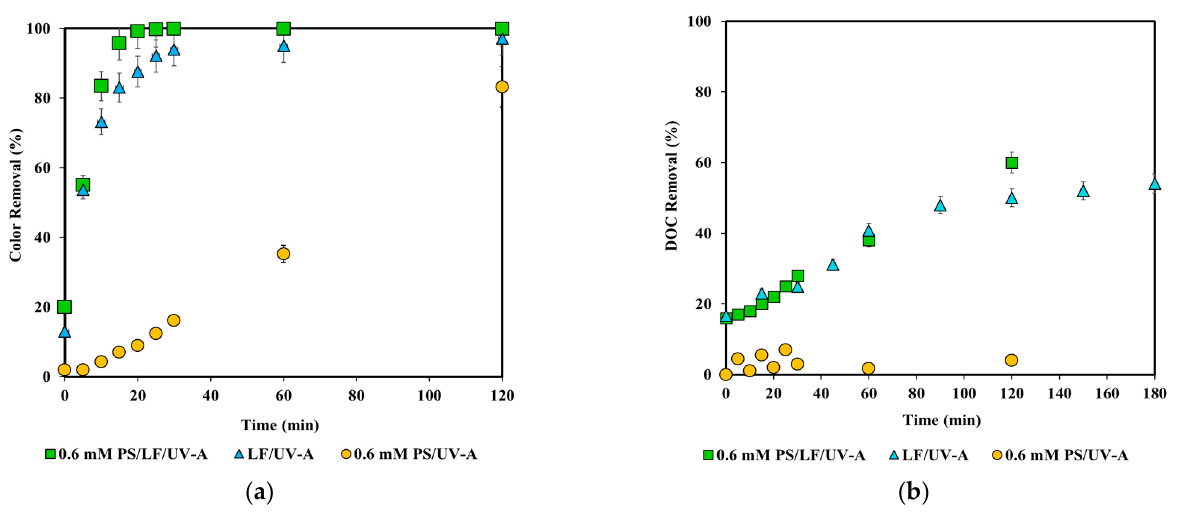
Figure 1. Color (peak absorbance) ( a ) and DOC ( b ) removal efficiencies obtained for LF/UV − A, LF/PS/UV − A, and PS/UV − A treatments. Experimental conditions: RB5 = 20 mg/L; pH = 3; LF = 0.5 g/L; PS = 0.6 mM; and I 0 = 0.5 W/L (UV − A).